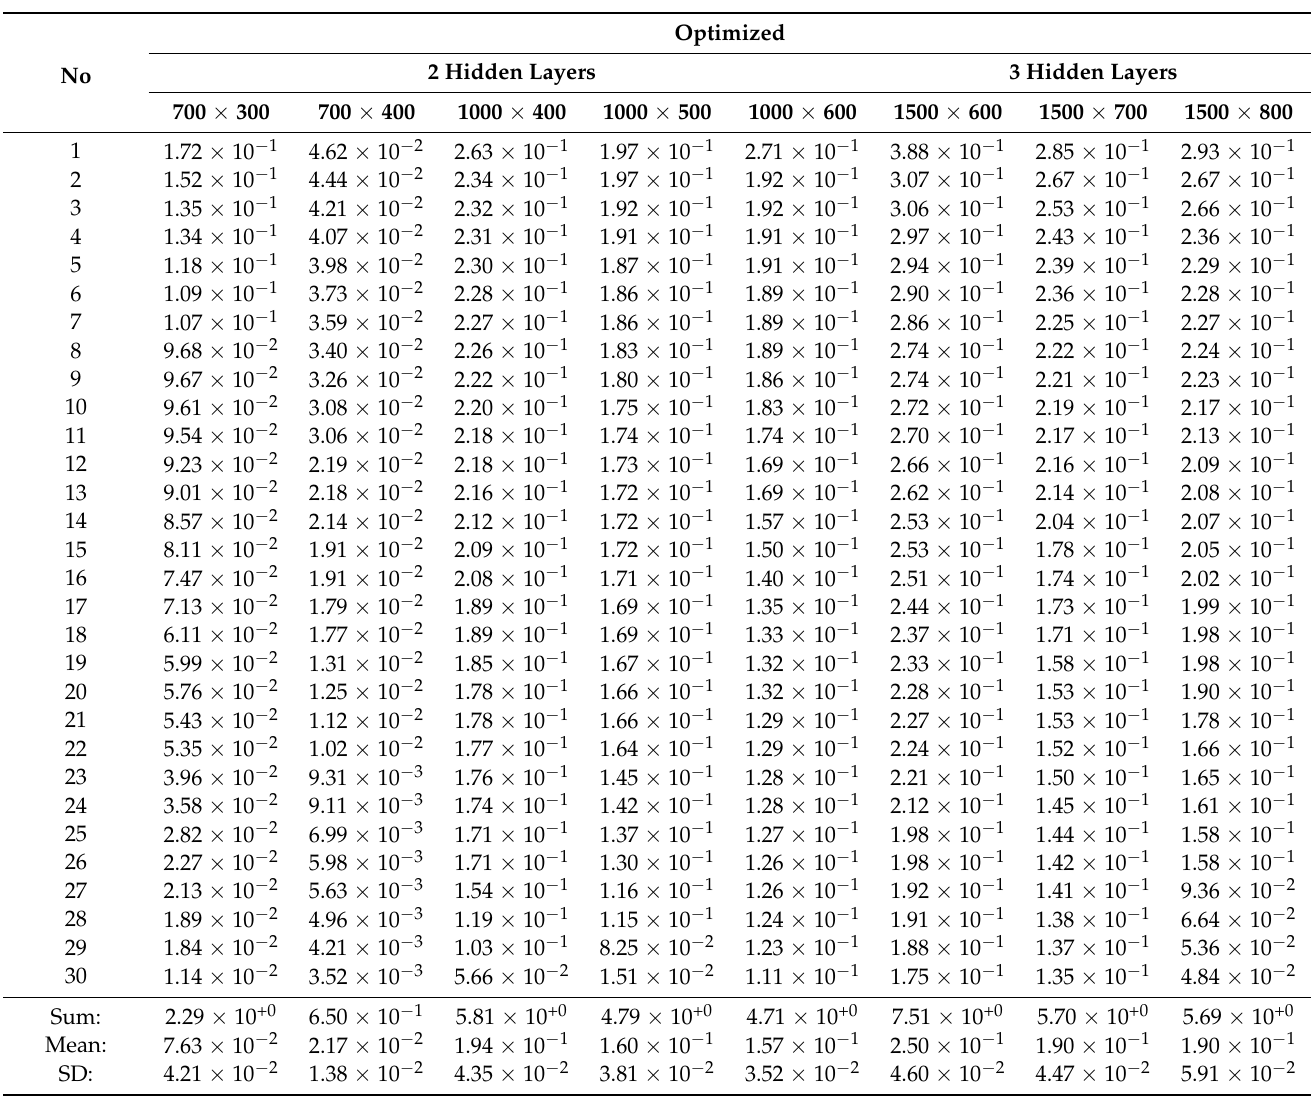
Table 5. 30 Experiments with optimized